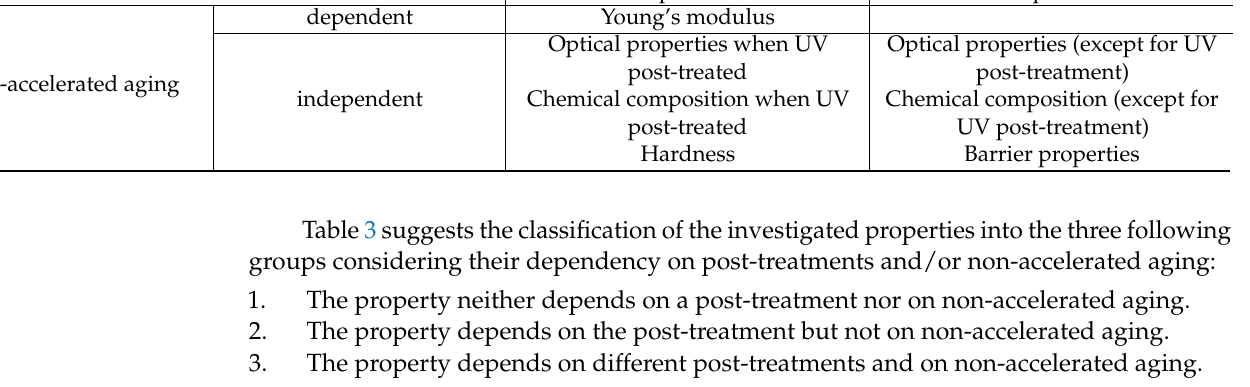
Table 3. Overview of the samples used for investigation of the aging impact on the mechanical properties. Post-Treatment dependent independent dependent Young’s modulus Optical properties when UV Optical properties (except for UV post-treated post-treatment) independent Chemical composition when UV Chemical composition (except for post-treated UV post-treatment) Hardness Barrier